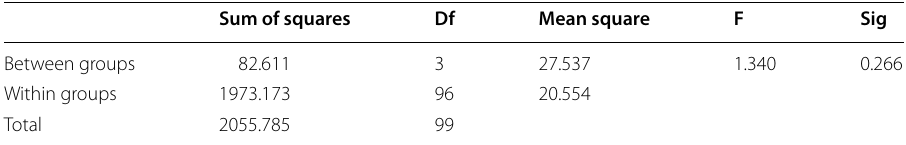
Table 5 The result of ANOVA on B1 Preliminary pre-test scores Sum of squares Df Mean square Between groups